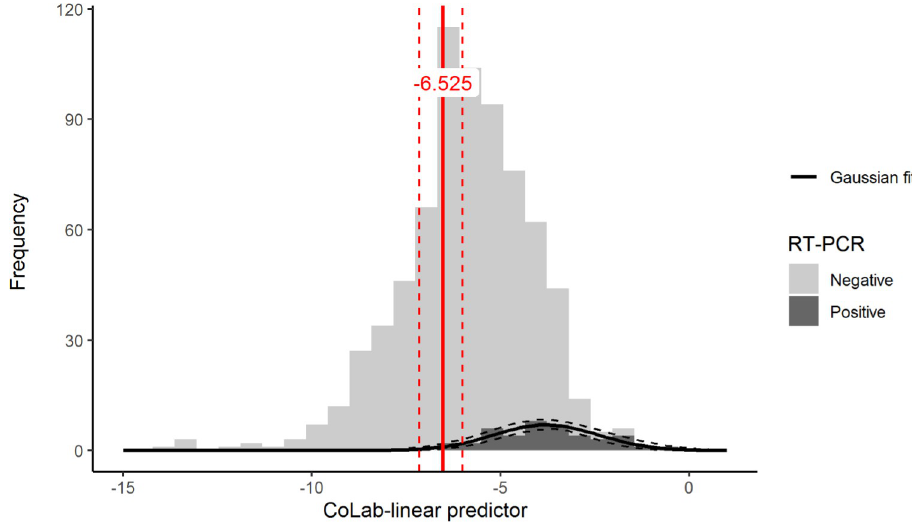
Fig 4. Histograms and fitted Gaussian distribution of the CoLab-linear predictor split by RT-PCR result. A normal distribution was fitted to the RT-PCR negative group (mean: -6.04, SD: 1.73), the dashed lines represent the 95% CI. The 5 th percentile of the Gaussian distribution is shown in red and dashed lines represent the 95% CI. Linear predictor values below this 5 th percentile are regarded as non-COVID-19.